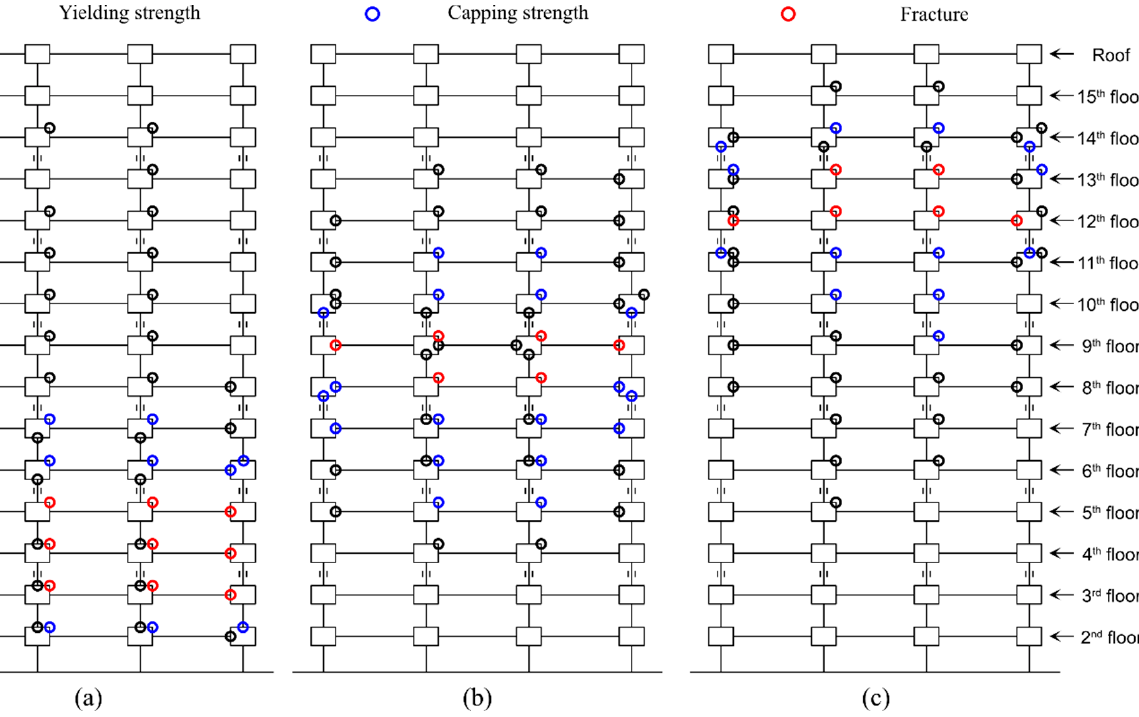
Figure 6. Plastic hinge distribution in pushover analysis for 15-story OMFs near collapse: ( a ) The 15-story W0-OMF; ( b ) 15-story W44-OMF; ( c ) 15-story W51-OMF.